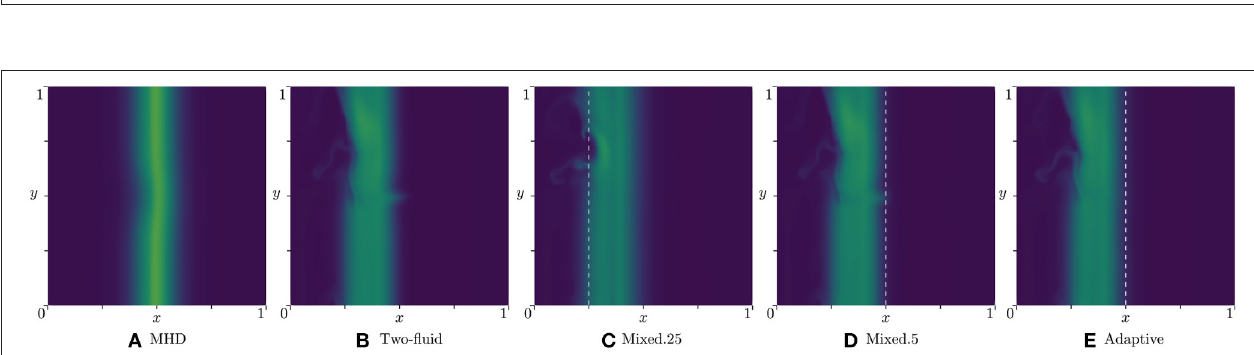
FIGURE 6 | Planar plasma switch density at t 1. The adaptive method has re-partitioned the domain variables. An instability at the density perturbation starts = developing in all models except for the Uniform MHD case.